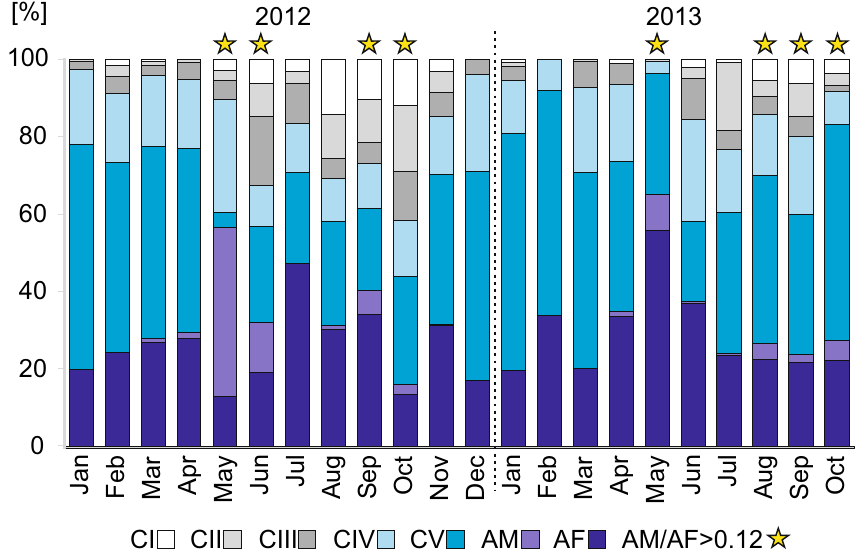
Figure 6. Oithona similis copepodite stages (CI–CV, AF–adult females, AM–adult males) copepodite stage structure in integrated water column (0–65 m). Yellow stars indicate sex ratio (AM/AF) higher than 0.12 56 .